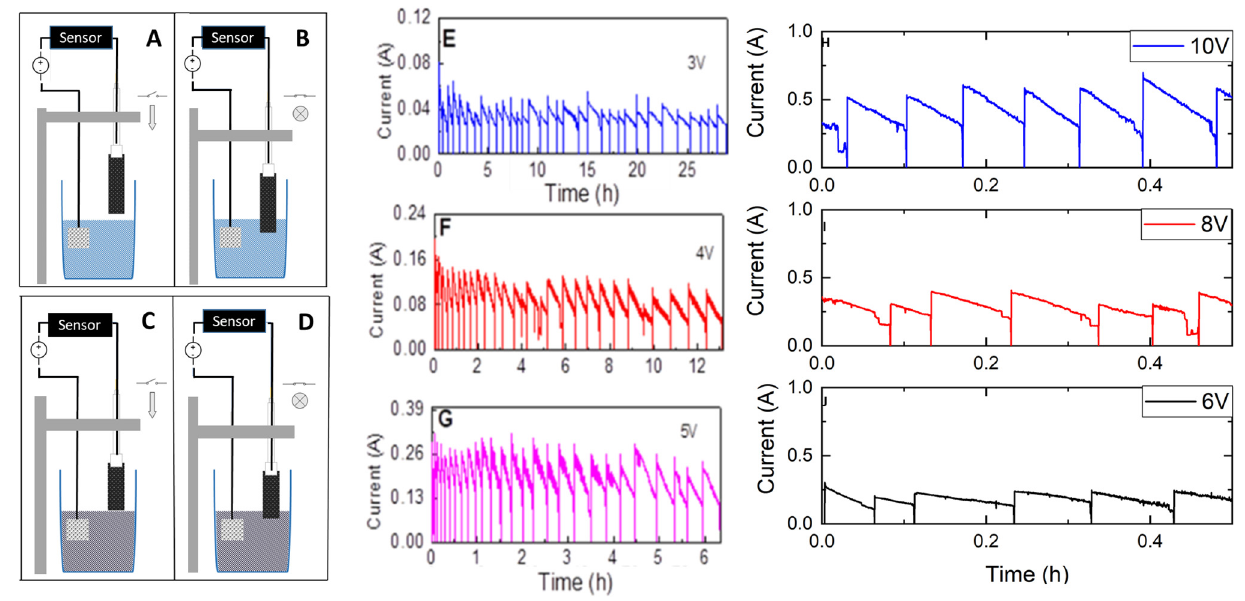
Figure 1. Principle of the automatic ECE system: ( A ) before ECE; ( B ) immersion of a fraction of the electrode; ( C ) the immersed portion was exfoliated; ( D ) re-immersion of a fraction of the electrode. Current and time plots recorded in 1.0 M NaOH during the ECE process at an applied voltage of: ( E ) 3.0 V, ( F ) 4.0 V, and ( G ) 5.0 V and in 0.5 M NaOH during the ECE process at an applied voltage of: ( J ) 6.0 V, ( I ) 8.0 V, and ( H ) 10.0 V.